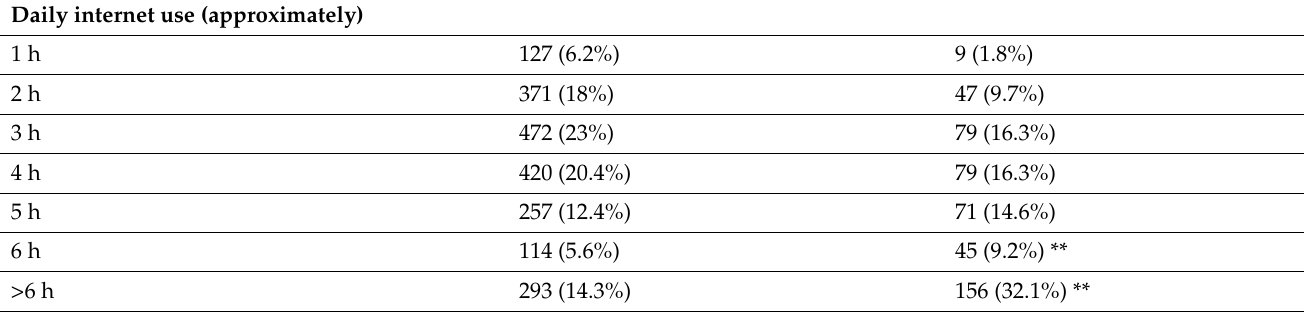
Table 6. Comparison of internet use in the study